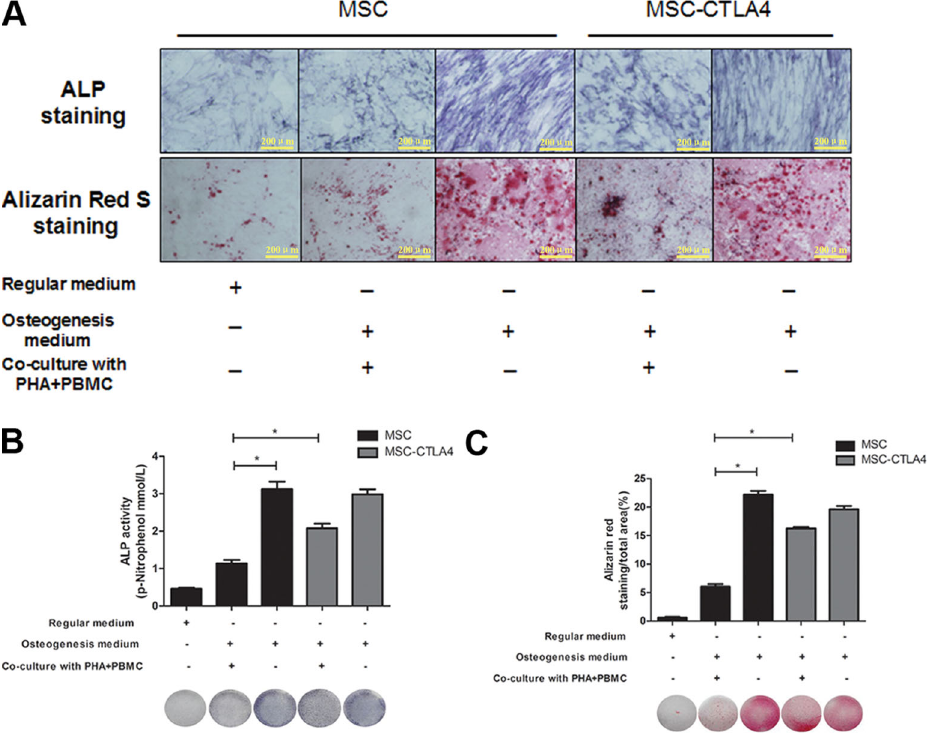
Figure 4. Alkaline phosphatase (ALP) activity and number of calcium nodules after 21-days culture in osteogenic medium. A , Images of ALP and Alizarin red S staining. B , ALP activity. C , Number of mineralized nodules determined quantitatively by Alizarin red S staining. MSC: mesenchymal stem cells; PHA: phytohemagglutinin; PBMC: peripheral blood mononuclear cells. Data are reported as means ± SD. *P o 0.05 (Student ’ s t